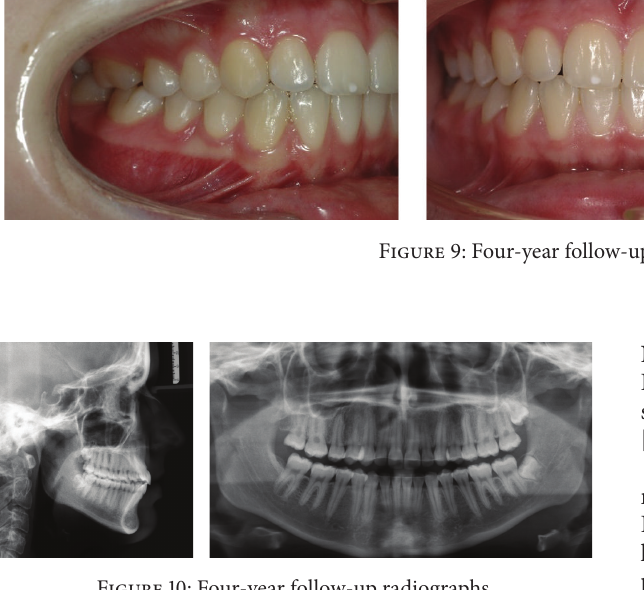
Figure 10: Four-year follow-up